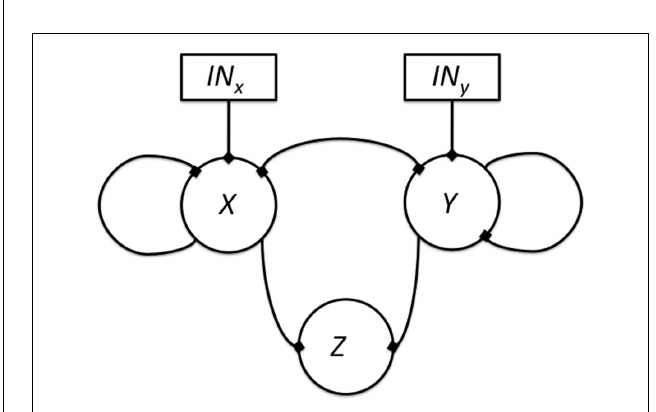
FIGURE 4 | Subgraphs to be inferred with epistasis analysis. The graphs of the examples explained in the main text are shown. All these subgraphs yield the same results with a classical epistasis analysis. INx (Input of X ) is included to meet assumptions 1, 2 and 3 of epistasis analysis, but it could be obviated, as it is commonly done (see Figure 2 ).The logical rules for each motif are: (A) x = IN x , y = x , z = y , (B) x = IN x ∧ y , y = IN y ∧ x , z = x XOR ¬ y .